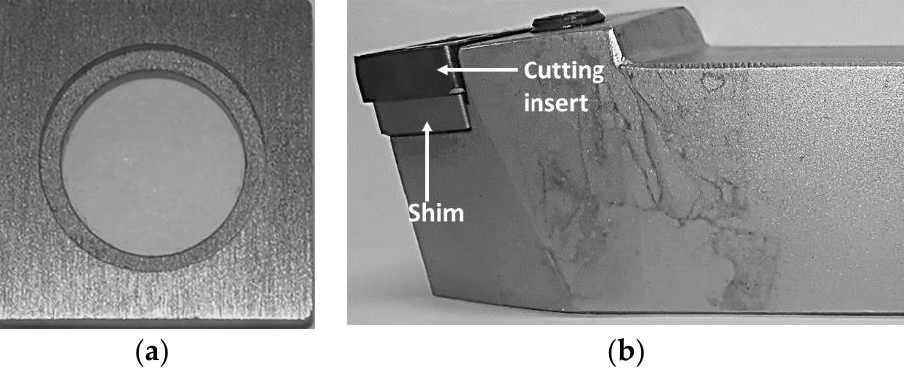
Figure 1. ( a ) Conventional shim and ( b ) shim placed between the cutting insert and the tool holder. Machined shims were directly collected from the commercial vendor (Palbit S.A., Albergaria-a-Velha, Portugal); per our request, the conventional shims (CS 120200) were ground at the vendor’s site to reduce thickness by 200 µ m to accommodate the 200 µ m surface